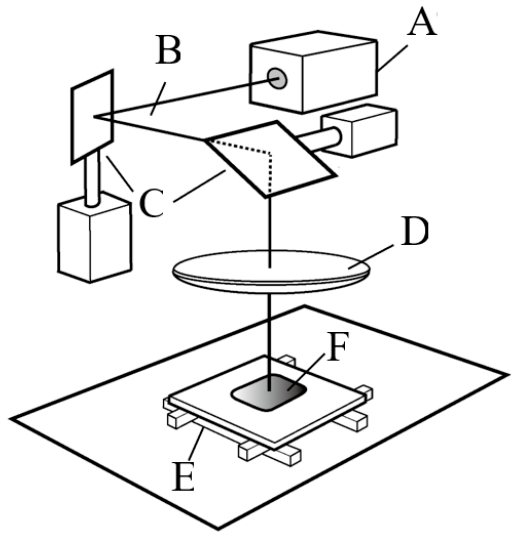
Figure 1. Schematics of microperforation process for titanium sheet. ( A ): Pulse laser, ( B ): Laser beam, ( C ): Galvano-mirrors, ( D ): Lens, ( E ): X-Y stage, ( F ): Workpiece.